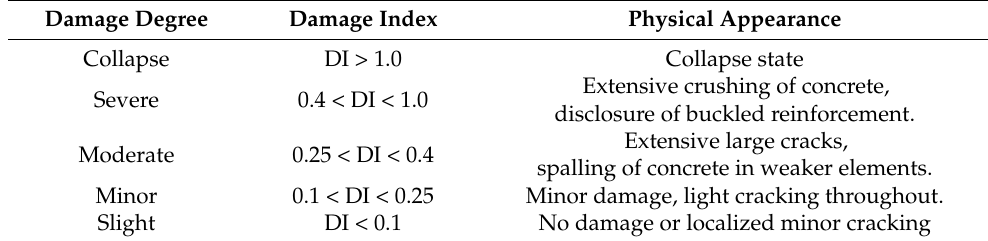
Table 1. Damage Index for RC